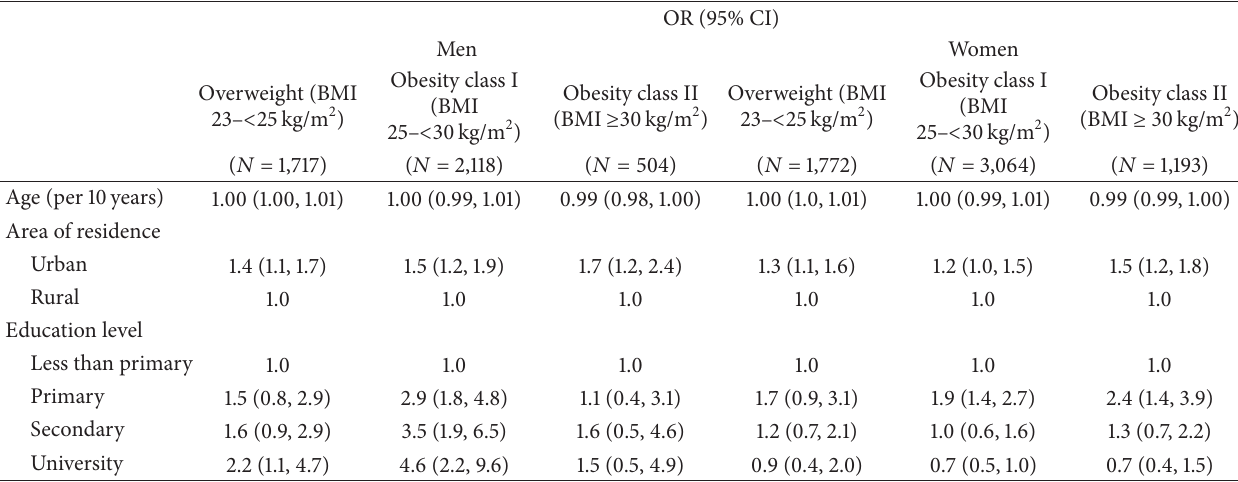
Table 2: Adjusted odds ratio (95% CI) for overweight and obesity associated with educational levels in Thai adults, 2009.